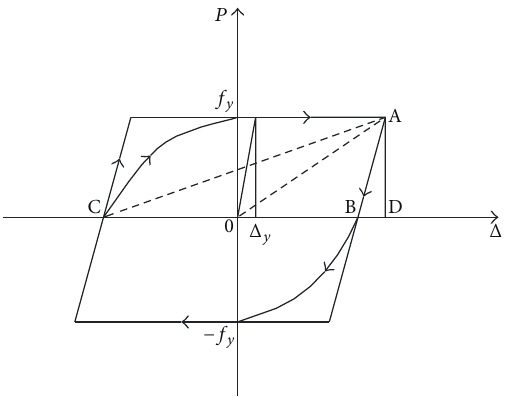
Figure 21: Hysteretic and energy dissipation capacity.